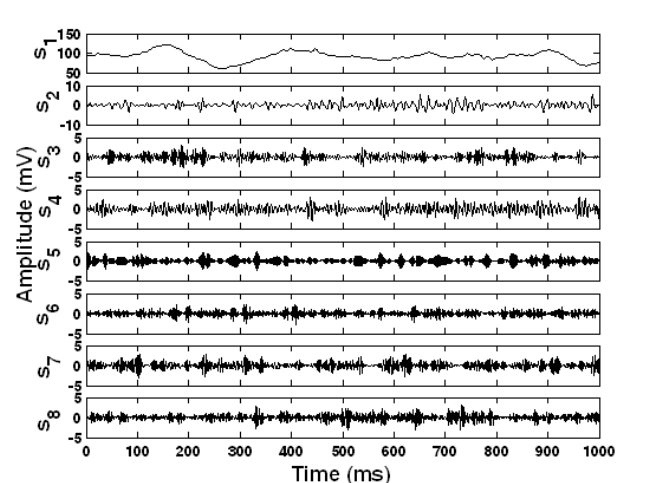
Figure 9. Wavelet packet decomposition of the seismic signal shown in Figure